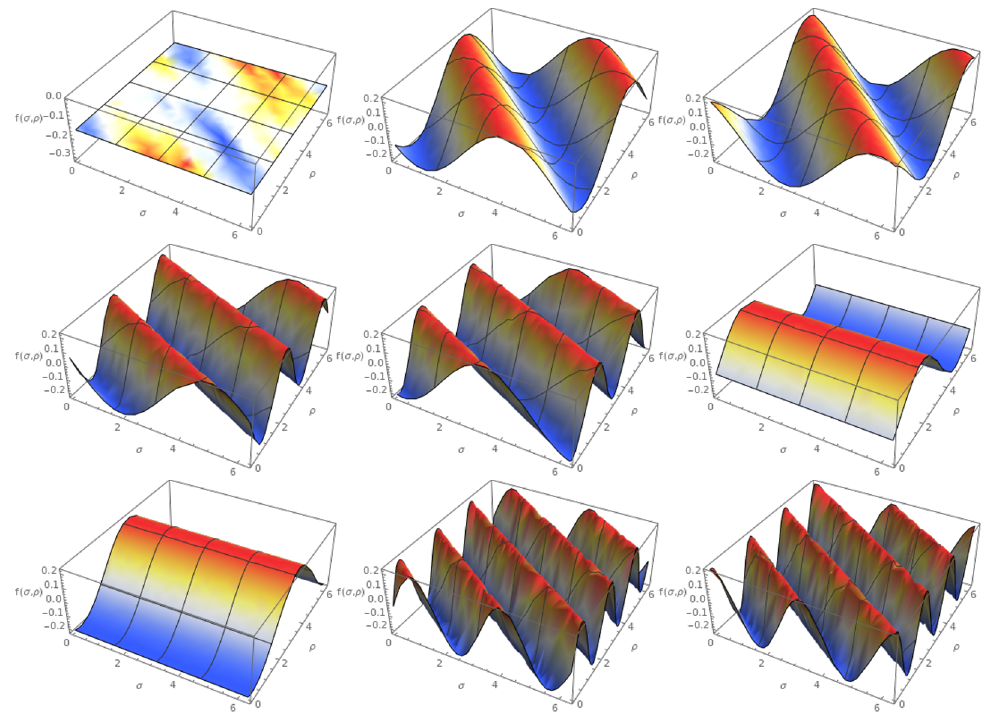
Figure 2 . First nine eigenfunctions of the differential operator for periodic boundary